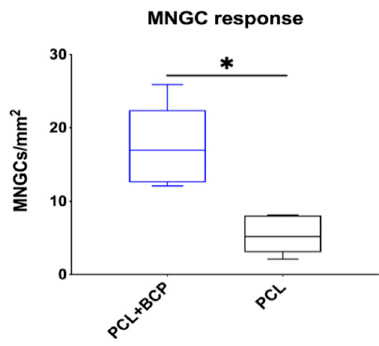
Figure 7. Histomorphometrical results of the measurements of the induction of multinucleated giant cells (MNGCs) at day 15 post implantationem within the subcutaneous connective tissue (* p <